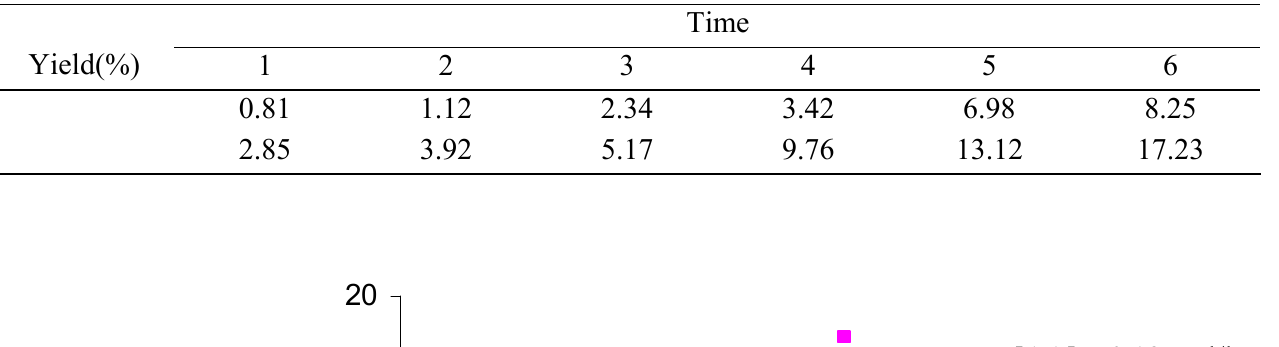
Table 5. Conversions with time for 10.75 mol/l of THF, 5.67 mol/l of phthalic anhydride, 2.5% of H- Maghnite 0.25M and the amounts of acetic anhydride were: a) 0.19 mol/l, b) 1.28 mol/l.